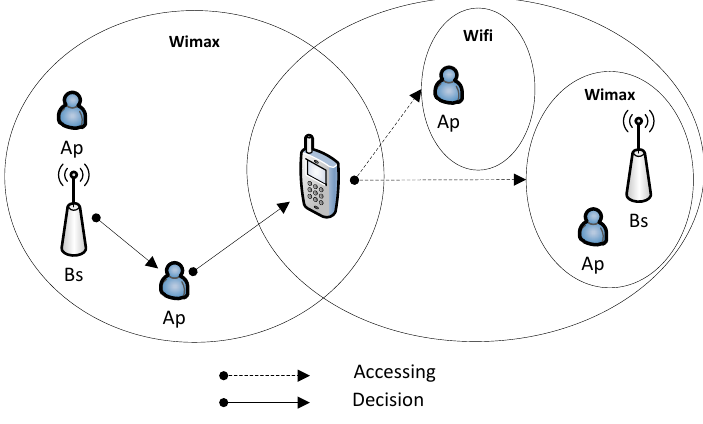
Figure 1. Network Selection